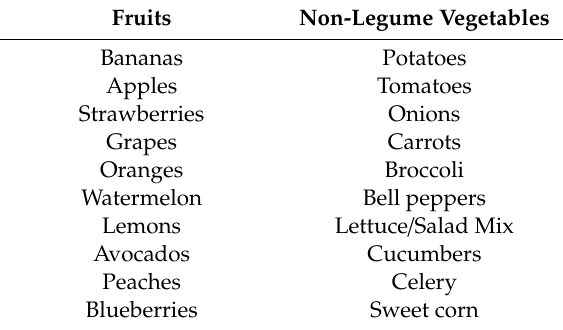
Table A4. Top 10 fruits and vegetables consumed in the US in 2019 [86].